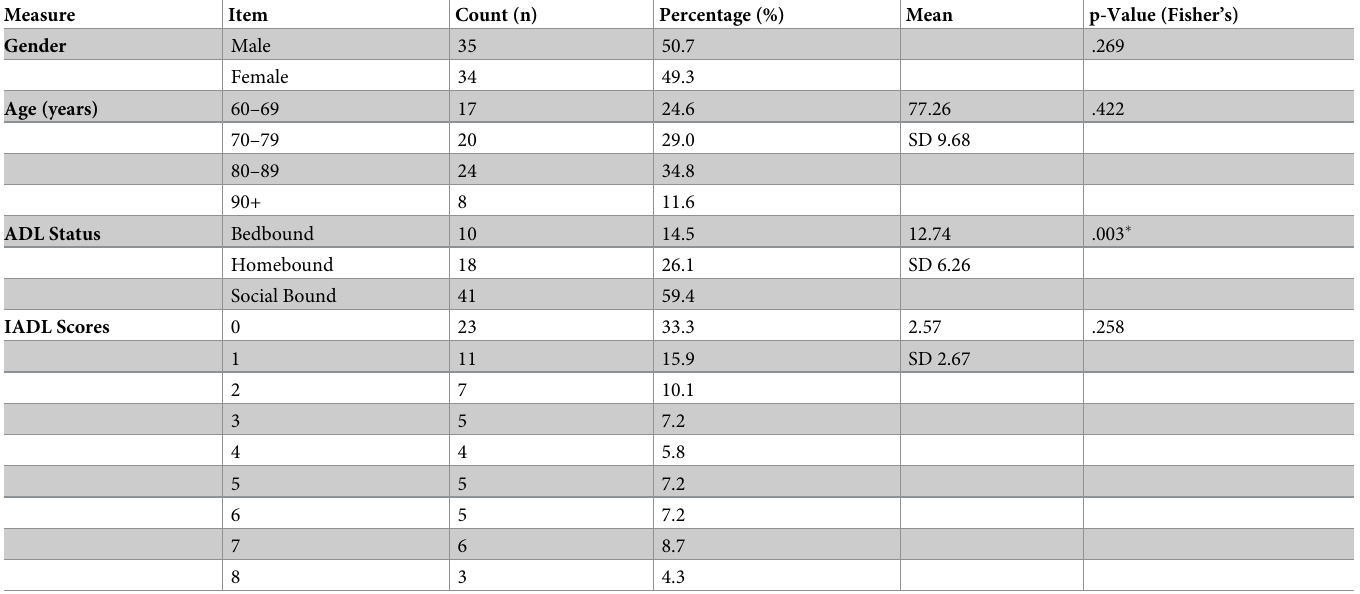
Table 3. Demographic characteristic of care recipient, ADL levels, IADL scores and correlation with caregiver burden. Measure